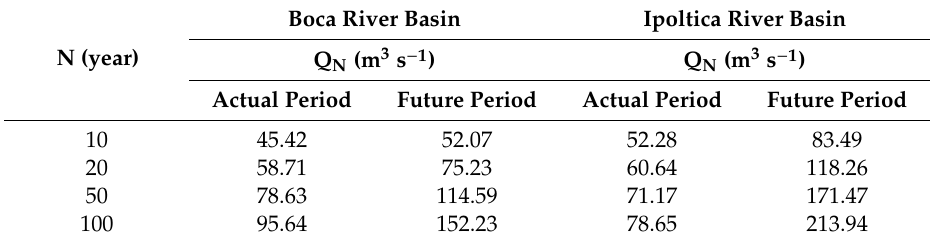
Table 13. Comparison of the design floods using the actual design values of the rainfall intensities and the design values of the rainfall intensities from the future